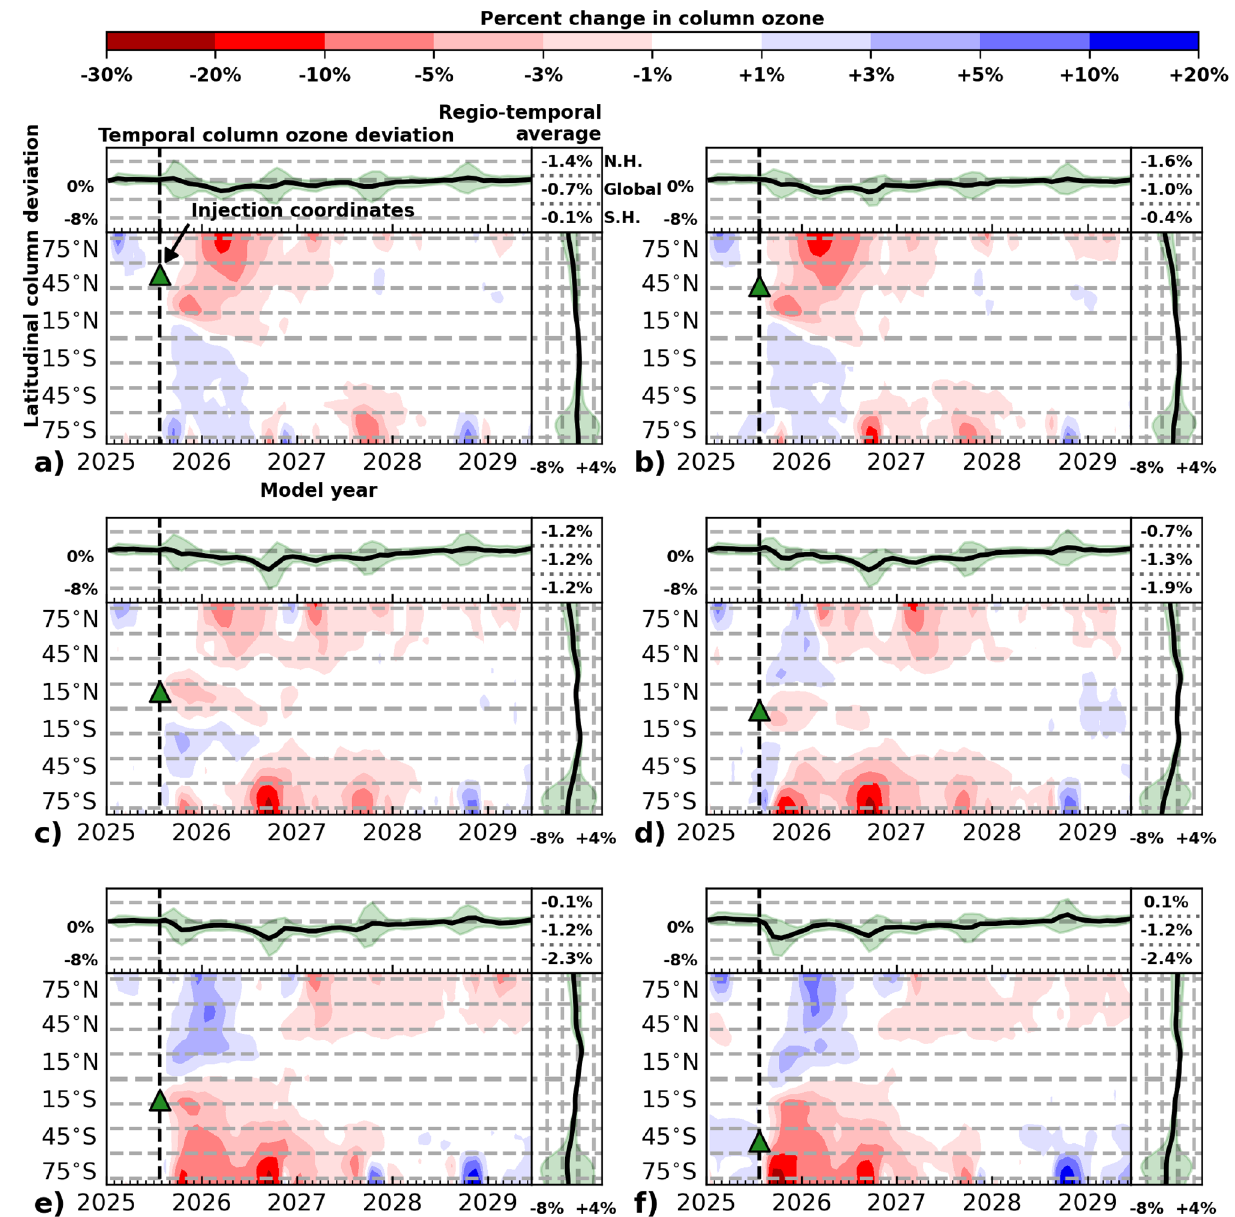
Figure 4. Ozone response to 5 Tg SO 2 injection (SSP3-70 July 25, 2025) as a function of latitude. The latitudes of eruption for panels ( a ) through ( f ) are: 58 and date of SO 2 injection indicated by a green triangle and a dashed line in each panel. In all graphical panels, computed metrics reflect the percent change in ozone between the volcanic eruption perturbation model ensemble and the baseline control ensemble shown for a 4-year time-horizon. Main panels (bottom left): Response of total column ozone in percent to the volcanic eruption as indicated in the colorbar (note that colorbar levels increment non-linearly). Top left panels: Global average response of total column ozone over time as indicated in the left scale. Bottom right panels: Response of total column ozone average over time versus latitude. Green shading in the top left and bottom right panels illustrates the variation (2 σ ) in the eruption perturbation ensemble; note that the increment between dashed lines in these panels is 4%. Top right corner panel: 3-year extra-polar hemispherical average (0 total column ozone deviation, ordered as NH, Global,